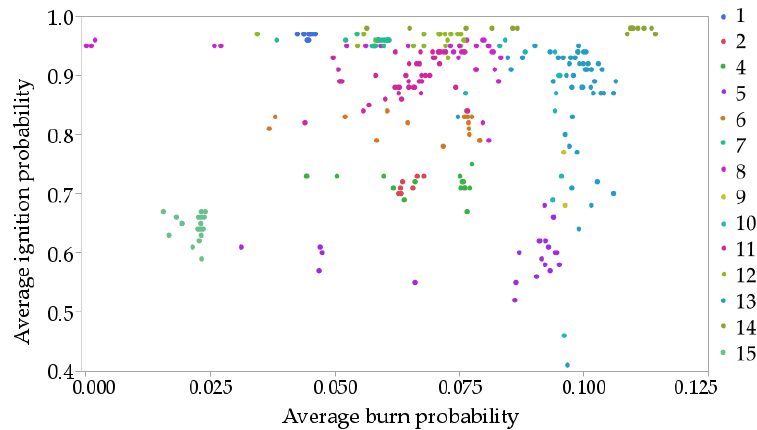
Figure 9. Scatter plot of ignition probability (IP) versus conditional burn probability (BP) for individual residential houses ( n = 306 structures). Each dot is related to a different residential house, and values correspond to the mean value in the HIZ [11]. The bubble color indicates the council cadaster polygon (Figure 1A). While BP values showed a wide distribution, most IP values were concentrated above 0.85. Overall, results tended to present clustered aggregations with respect to the council.